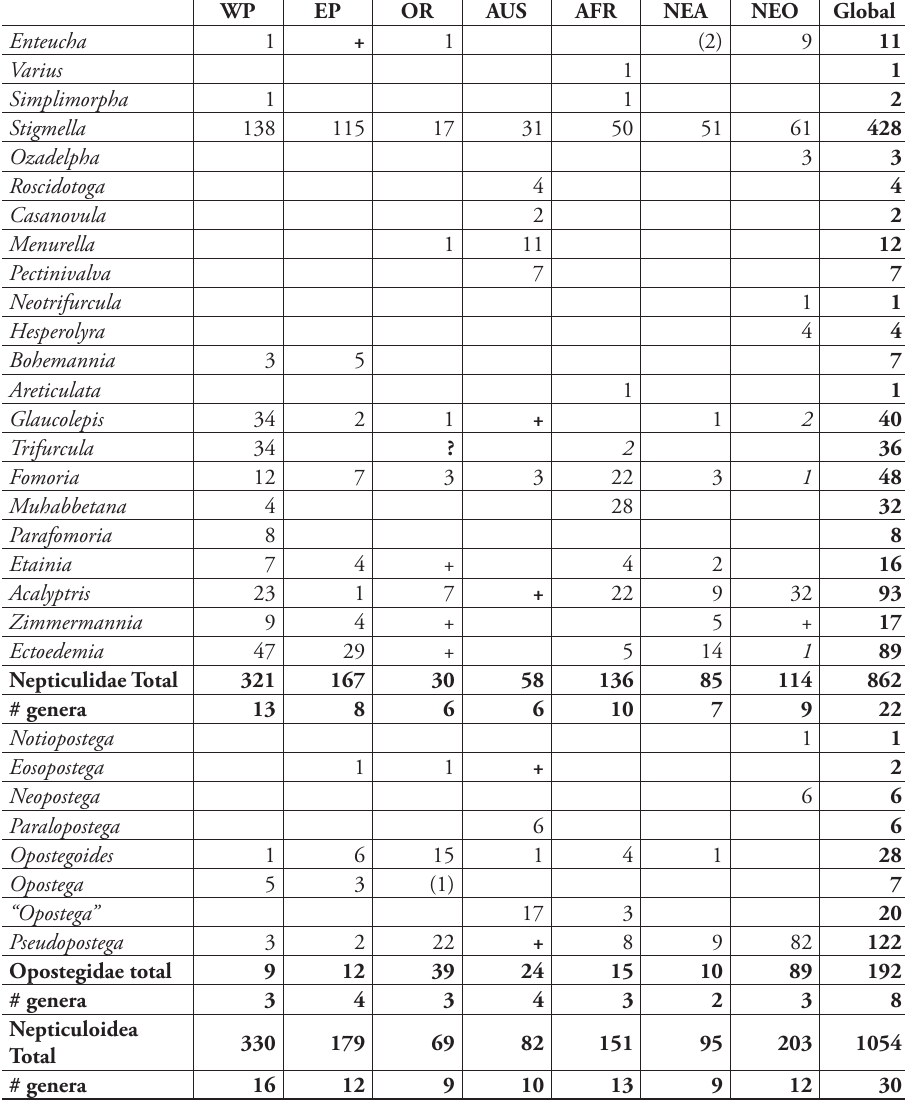
Table 4. Diversity of extant Nepticuloidea per geographic region and globally. Numbers are validly de- scribed species. When only unnamed species of a certain genus are known from a region this is indicated by a plus sign, brackets indicate occurrence just at the edge of the region. When generic assignment is uncertain, the number is given in italics